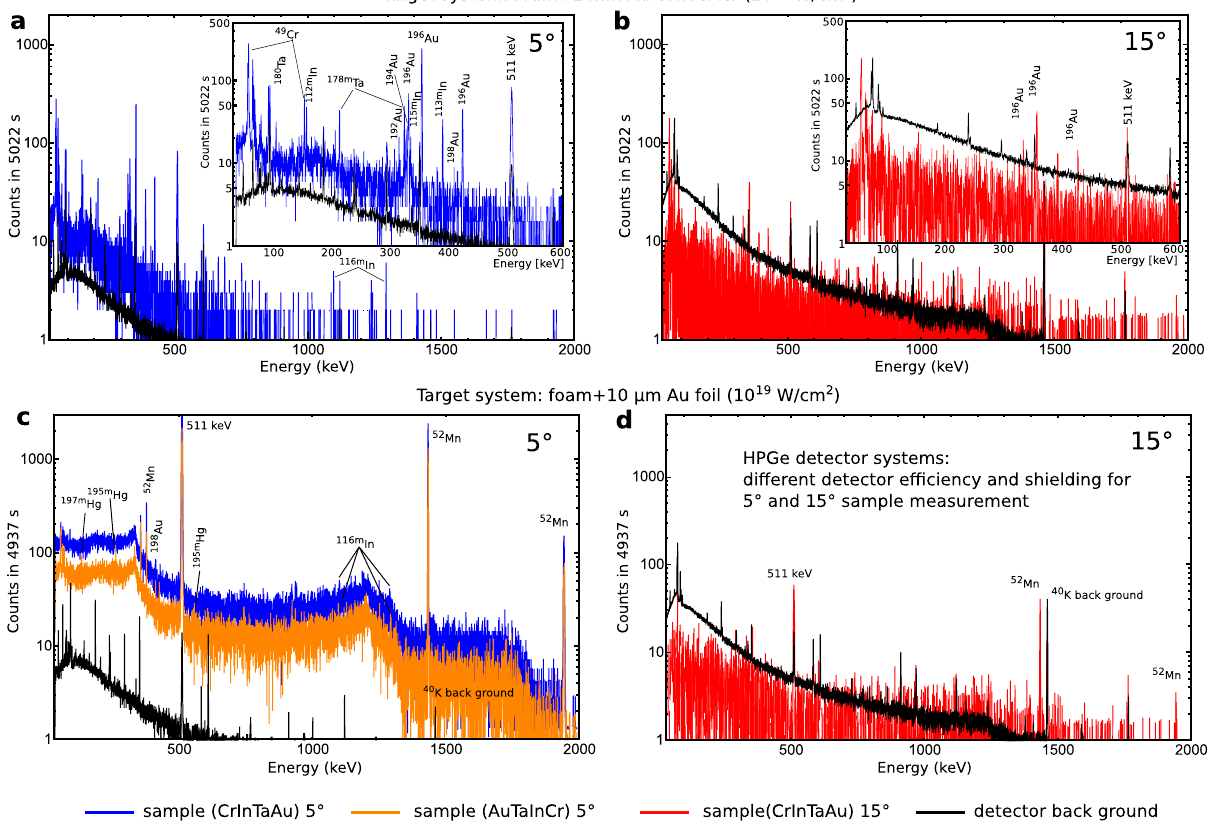
Fig. 7 Gamma spectrum. Results of the gamma spectroscopy of the activated samples: a and c at 5 ∘ (blue and orange spectra), b and d 15 ∘ (red spectra) for the laser-target setup scenarios. The black spectrum in each panel represents the detector back ground spectrum. Blue and orange colors are used for different sequences of activation plates in the stack. The unequal count rate of the back ground between the panels (a) , (c) and (b) , (d) is caused by the differently HPGe detector stations with its own back ground shielding. Results are shown after subtraction of the detector background. An important indicator for signal differences between 5 ∘ and 15 ∘ is the pulse height of the annihilation line at 511 keV, because the most activated isotopes are β +